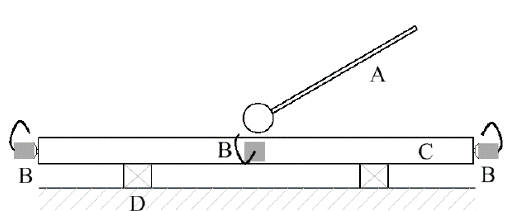
Figure 2. Modification chamber scheme: ( 1 ) PC; ( 2 ) switchboard; ( 3 ) measuring box; ( 4 ) condensate resorvoir; ( 5 ) steam generator; ( 6 ) thermal modification chamber; ( 7 ) fan; ( 8 ) heating element; ( 9 ) exhaust fan.